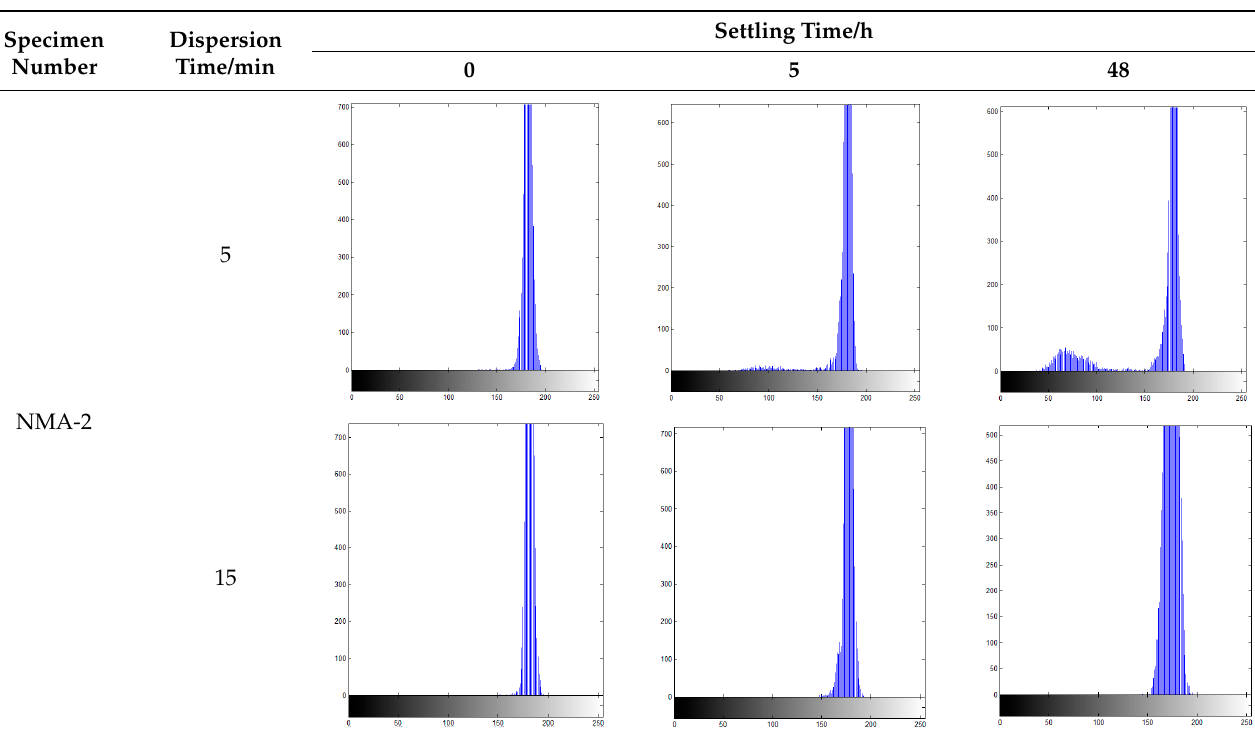
In the formula, A and B are coefficients; k is expectation; f is variance.